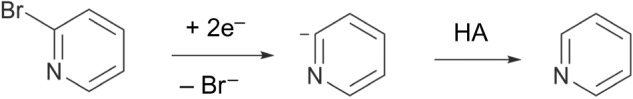
Electroreduction of o-bromopyridine with a hydrogen source.